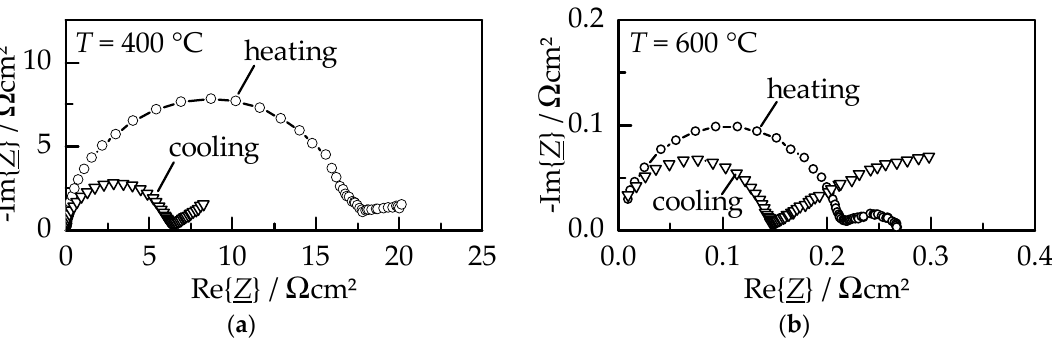
Figure 6. Normalized impedance spectroscopy data of a GDC10 film (with a thickness of 1.2 µm) on platinum interdigital electrodes (in air), upon initial heating and upon subsequent cooling (after a maximum temperature of 1000 °C). Shown are the normalized spectra at ( a ) 400 °C and ( b ) 600 °C.